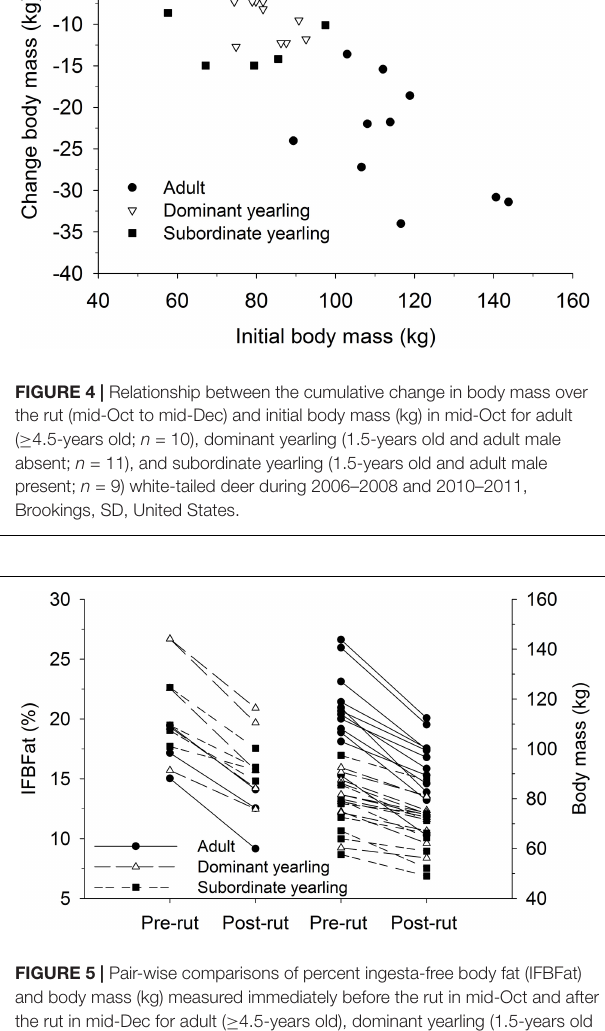
FIGURE 7 | Relationship between mean dry matter intake relative to metabolic body mass (g/kg 0 . 75 /day) and serum testosterone (ng/ml) during week 43 for adult ( ≥ 4.5-years old; n = 10), dominant yearling (1.5-years old and adult male absent; n = 11), and subordinate yearling (1.5-years old and adult male present; n = 8) white-tailed deer during 2006–2008 and 2010–2011, Brookings, SD, United